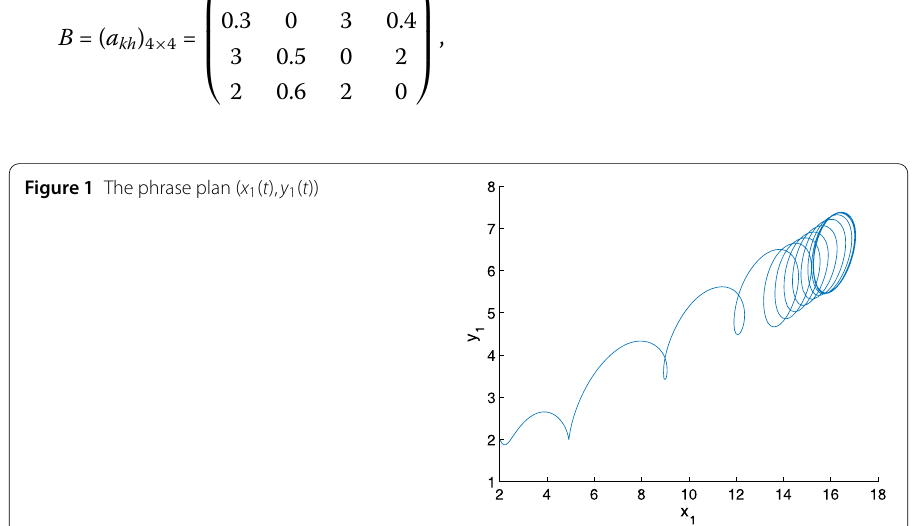
Figure 1 The phrase plan ( x 1 ( t ), y 1 ( t